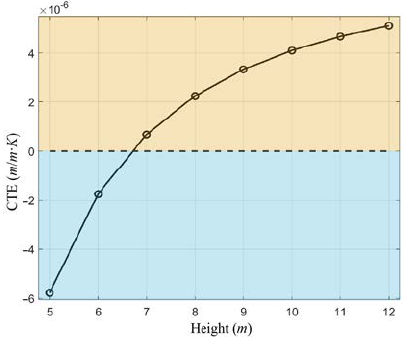
Figure 11. CTE variance with respect to the geometry design. Table 3. Results of effective CTE in thickness direction in several height parameters.